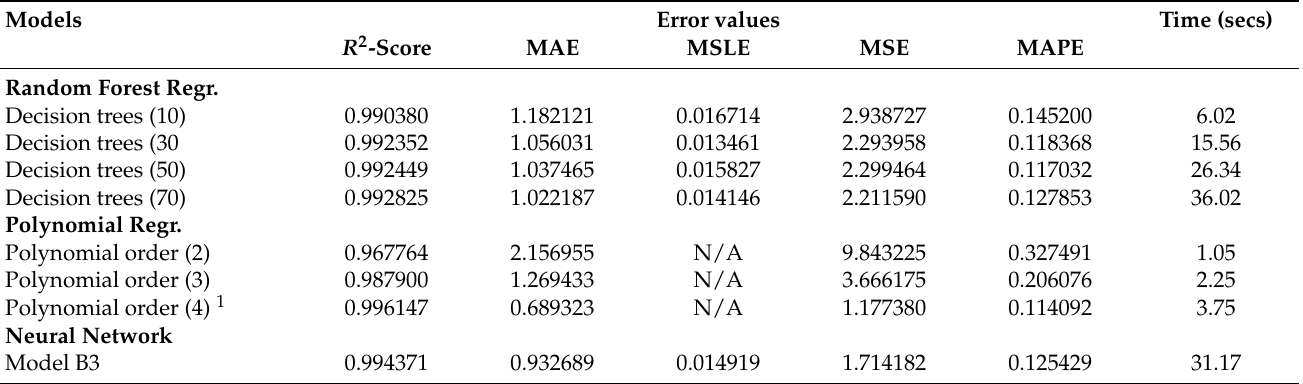
Table 8. Error values and computation time for Model B3, polynomial regression and random forest